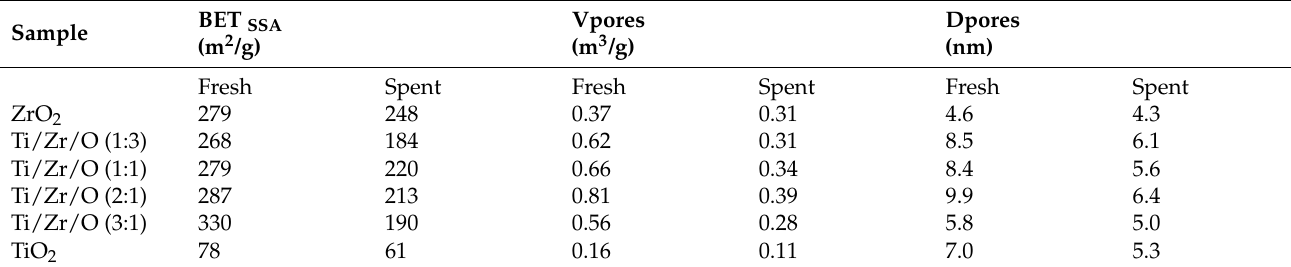
Figure 7 . Furfural conversion and product selectivities (%) with respect to the time on stream (h) using Ti/Zr/O (1:1). Reaction conditions: [FU] = 67 mM, τ = 10 min, T = 180 °C, m cat = 0.76 g. Table 2. Specific surface area, mean pore volume and mean pore diameter of the Ti/Zr/O mixed oxide with different compositions obtained through BET and BJH equations; comparison between fresh and used (spent)